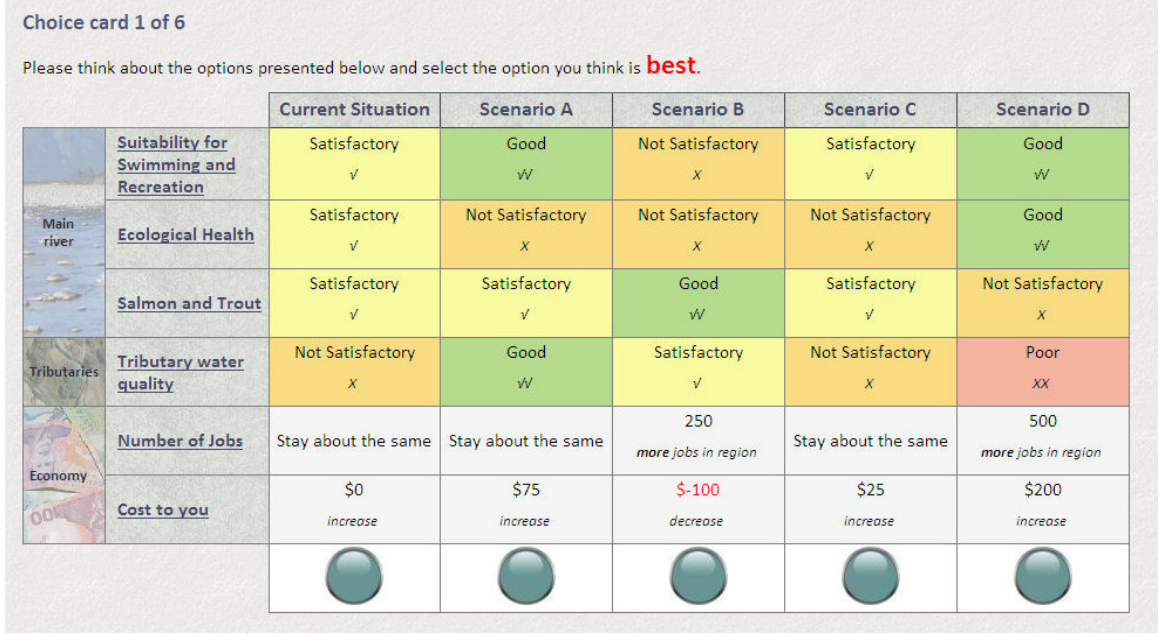
Figure 2. Example of a choice